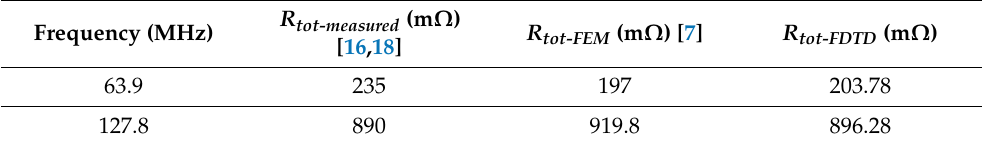
Table 3. Total coil resistance from experiments [18] reduced by soldering losses [16] and FEM [7] and FDTD